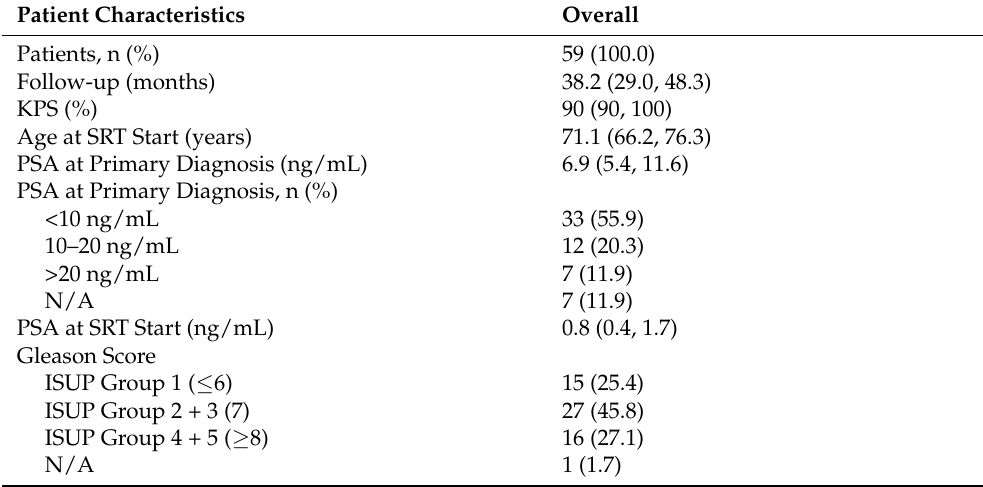
Table 1. Patient